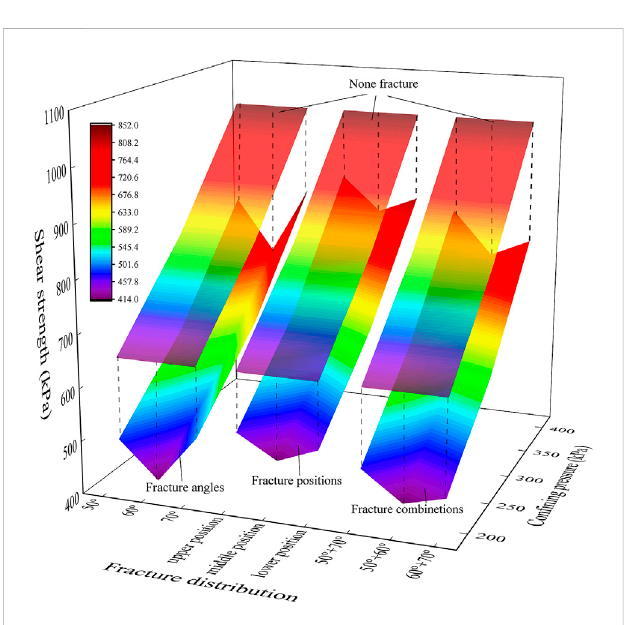
FIGURE 7 Shear strength envelope surface in the three-dimensional space of fracture distribution-con fi ning pressure-shear